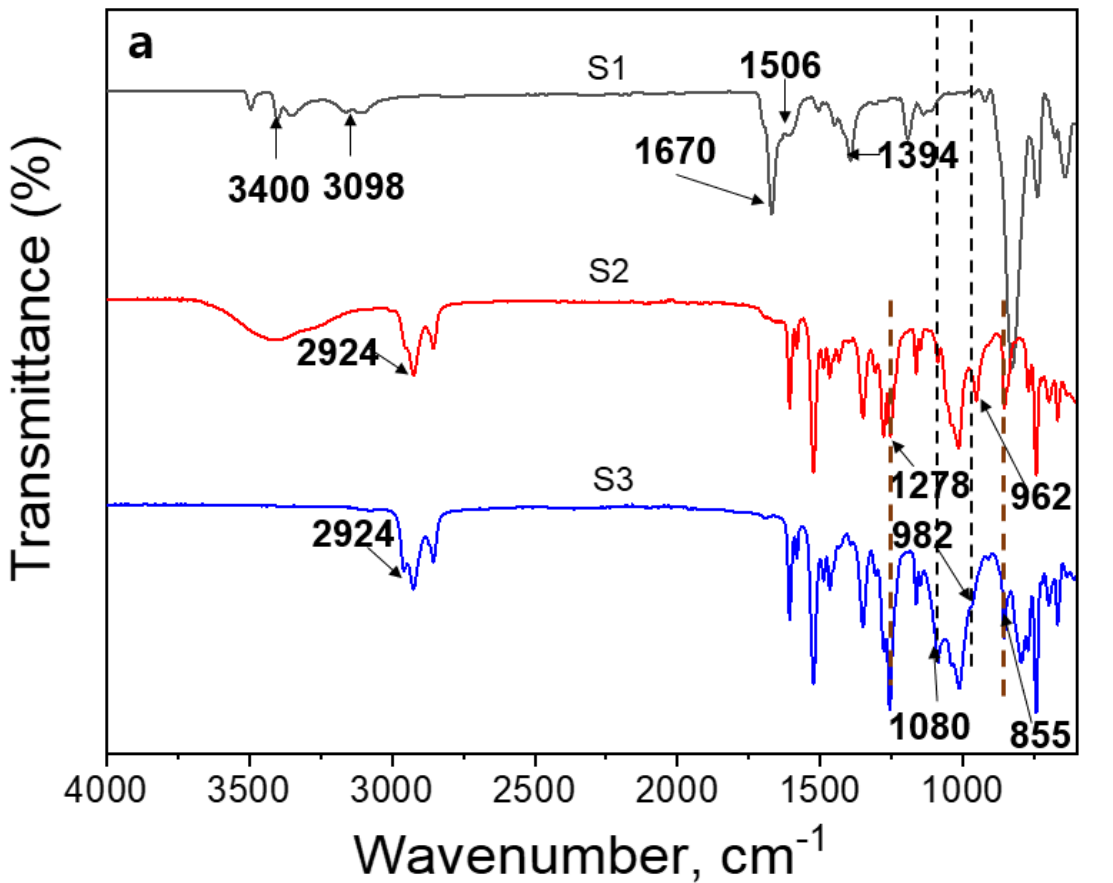
Figure 3. FT-IR spectra of the bis-meta- NICO-PF 6 (S1) and Type 2 membrane before (S2) and after incubation (S3) with phosphate.